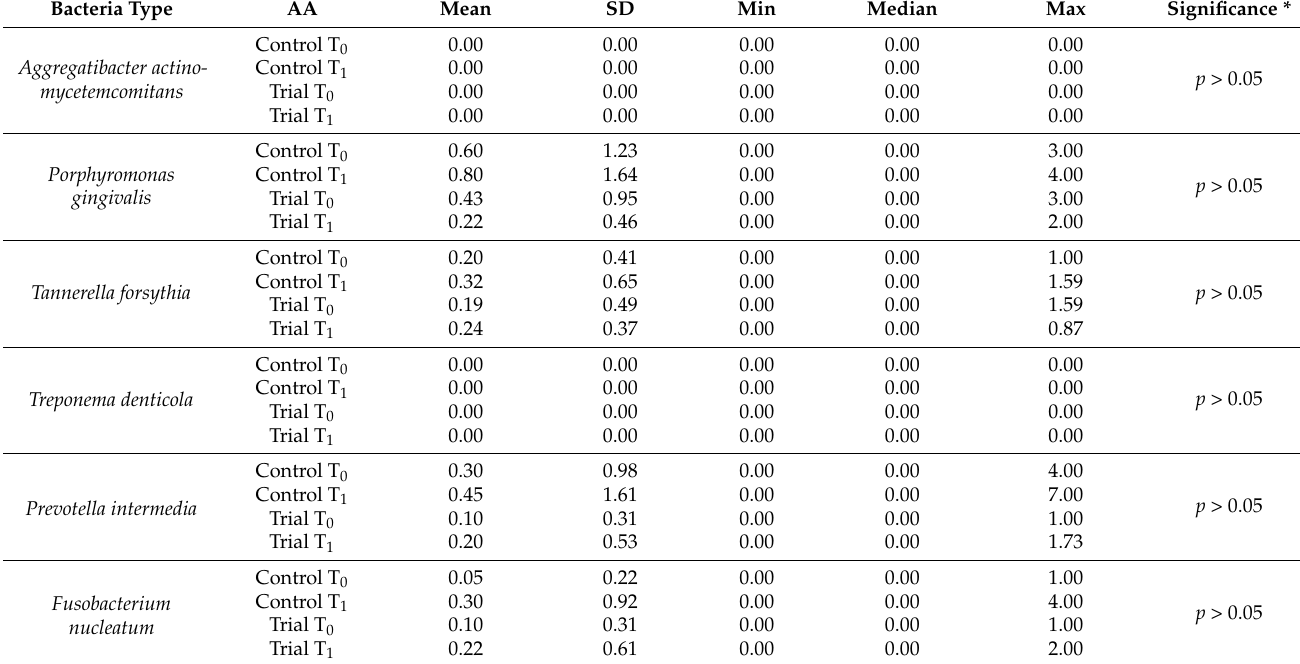
Table 5. Descriptive statistics of each bacterial count expressed as